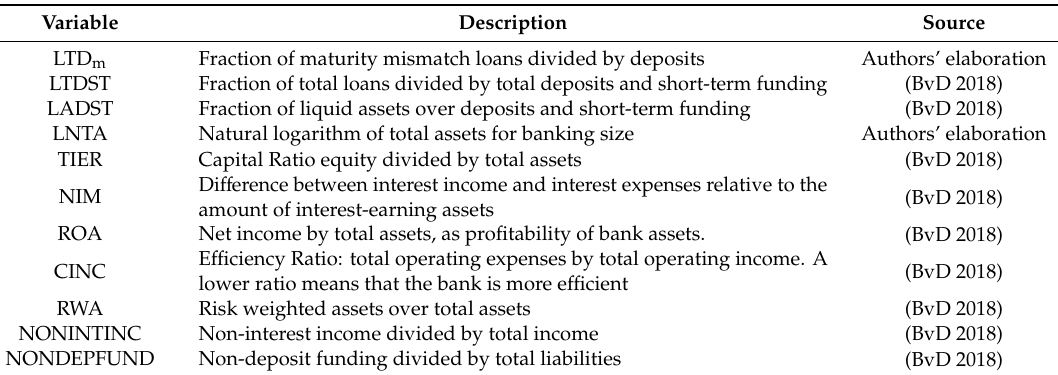
Table A1. Description of